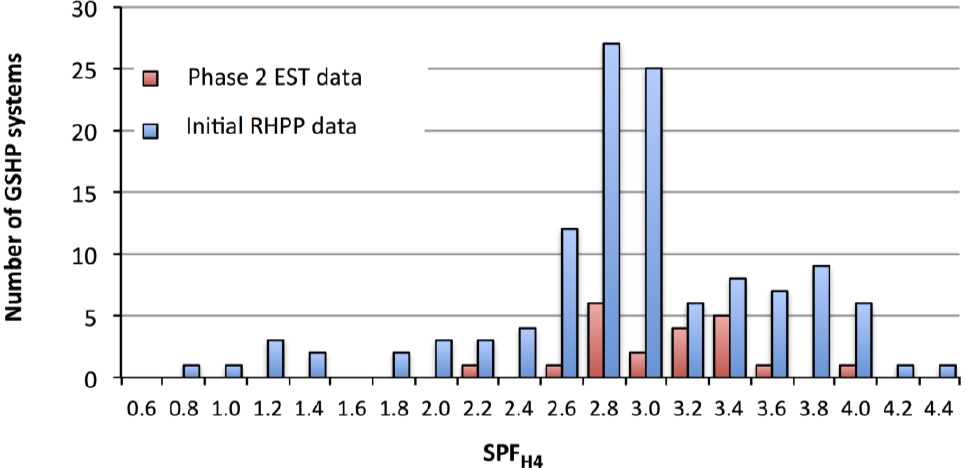
Figure 8. Seasonal Performance Factor data (SPF programme data [47] and compared with the EST national field trial Phase 2 data [64]. Data from